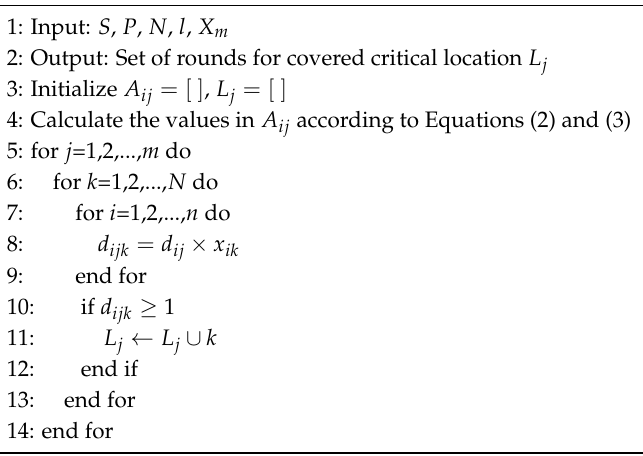
Algorithm 2 Matrix-based Decoding